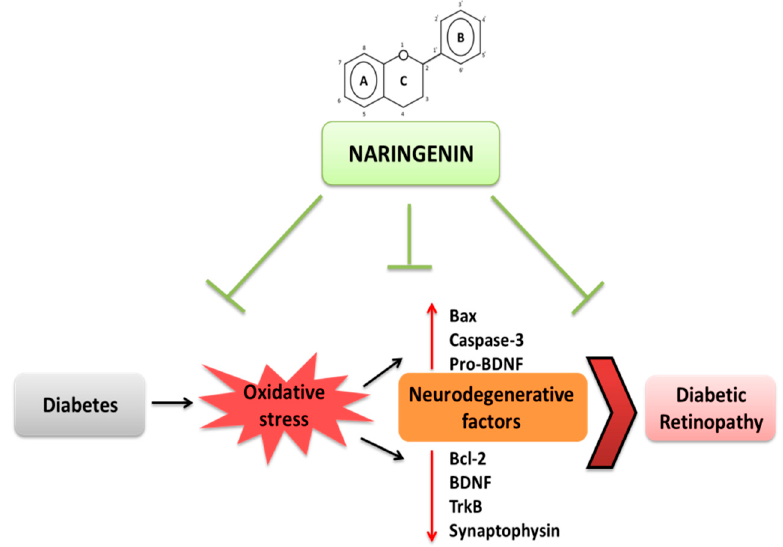
Figure 6. Schematic diagram summarizes diabetes-induced oxidative stress that leads to diabetic retinopathy. The findings of the current study showing that diabetes-induced oxidative stress activates apoptosis and decreases neurotrophic support leading to neuronal damage. Treatments with naringenin that target diabetes, oxidative stress and neurodegenerataive factors might be effective therapeutics in attenuating retinal neurodegeneration in diabetic retinopathy. Bcl-2; B cell lymphoma 2. Bax; Bcl-2 associated X protein. TrkB; Tropomyosin receptor kinase. BDNF; brain derived neurotrophic factor.